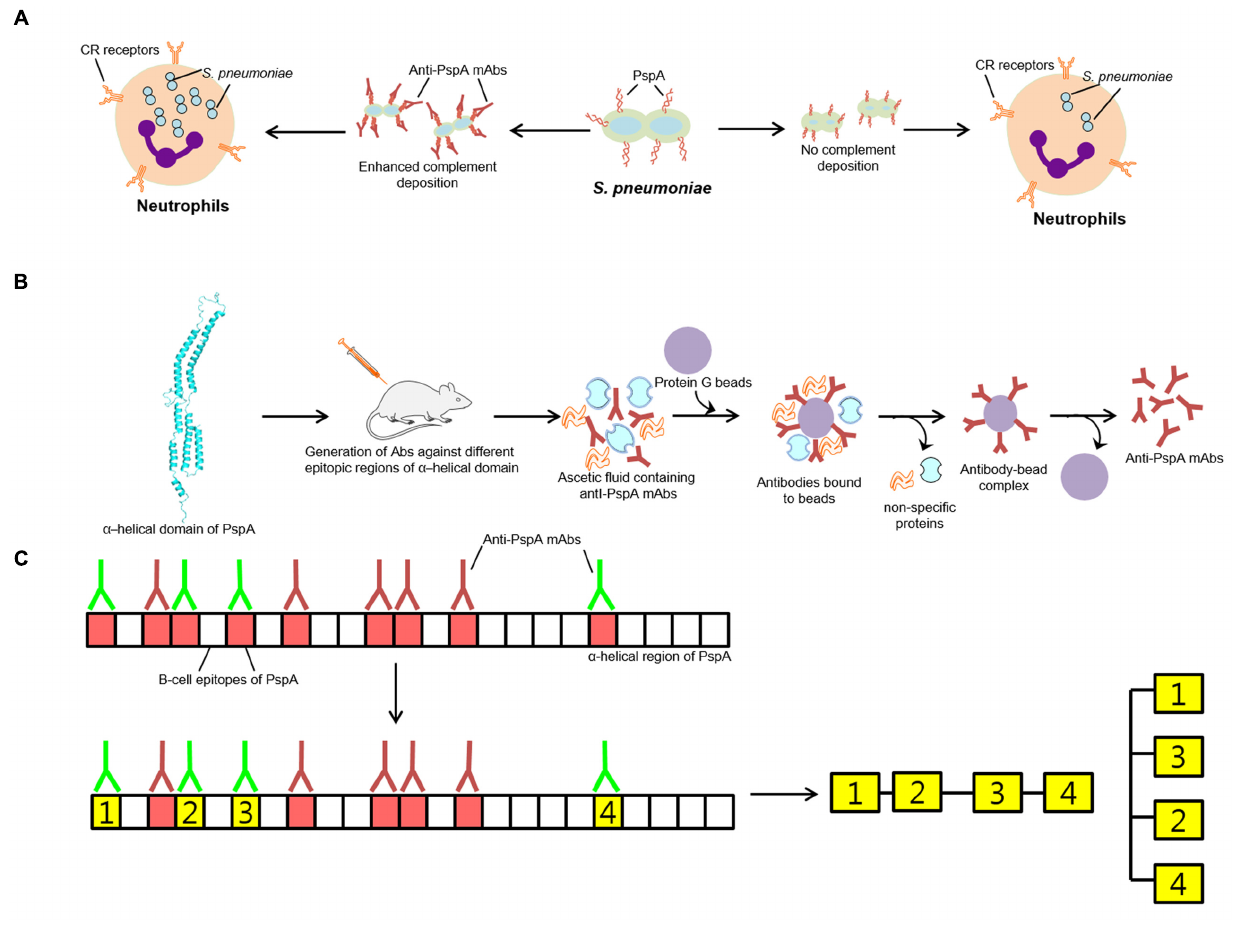
FIGURE 2 | Role of PspA in protection. (A) PspA imparting resistance against engulfment by neutrophils. Pneumococcus showing more PspA on the surface shows less complement deposition and as such less killing by neutrophils. (B) Mechanism adapted for the generation of anti-PspA- mAbs. (C) Graphical demonstration of the production and characterization of antibodies (anti- PspA-mAbs) generated against different combinations of selected PspA epitopes of Red and green color antibodies represent non-protective and protective antibodies, respectively. The green block represents epitopic regions of PspA that elicit generation of protective